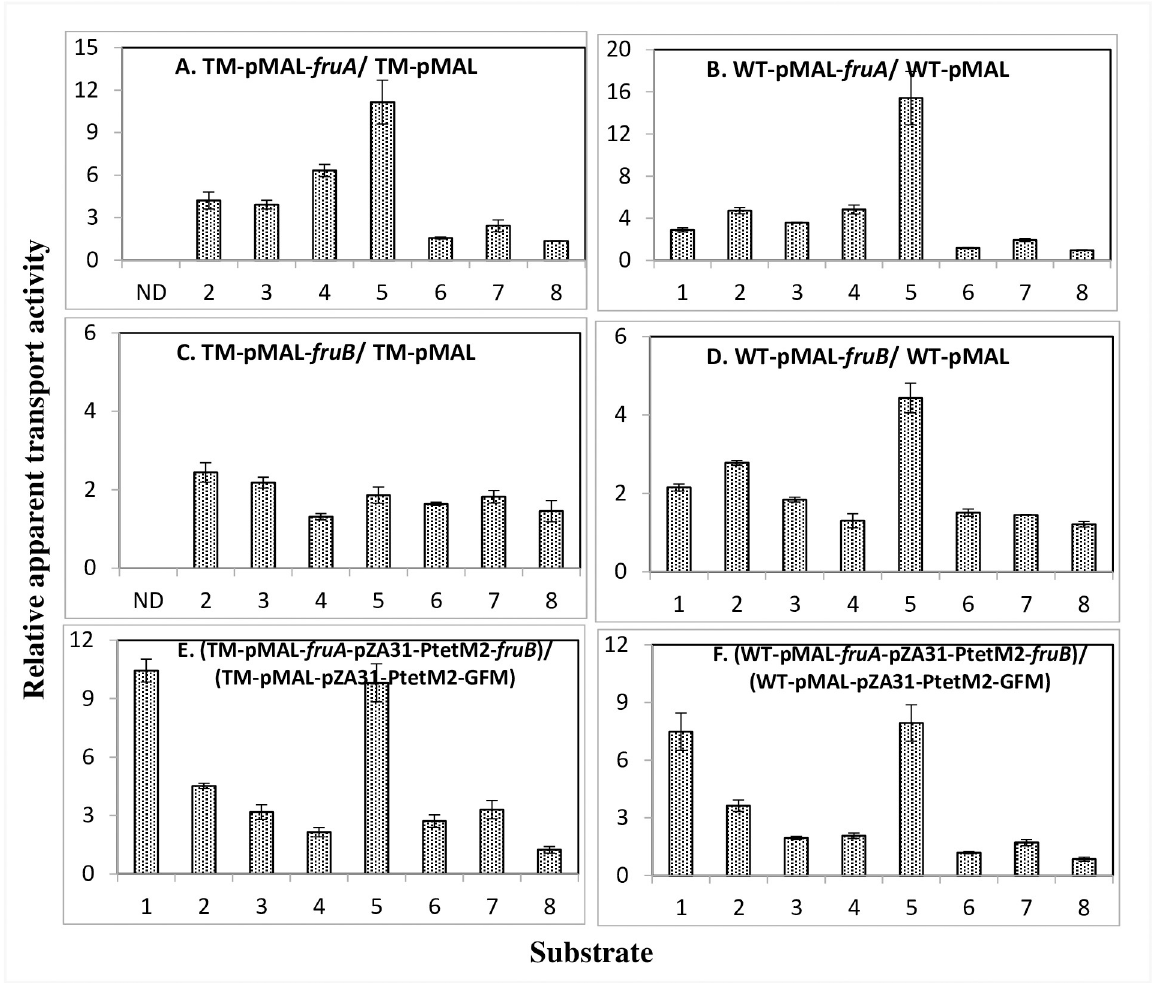
Fig 3. Ratios of apparent transport activities for various sugars (PTS substrates and galactose) by wild type E . coli BW25113 (WT) and its fruBKA triple mutant (BW25113 -fruBKA : kn (TM) over-expressing individual or combined fruBKA operon genes. Ratios of apparent transport rates for [ 14 C]sugar uptake in wild type (WT) and Δ fruBKA mutant backgrounds over-expressing individual or combined fruBKA operon genes as presented at the tops of the figures: A. fruA in the TM strain. B. fruA in the WT parental strain. C. fruB in the TM strain. D. fruB in the WT parental strain. E. fruA and fruB in the TM strain. F. fruA and fruB in the WT parental strain. 1, Fructose; 2, Mannitol; 3,